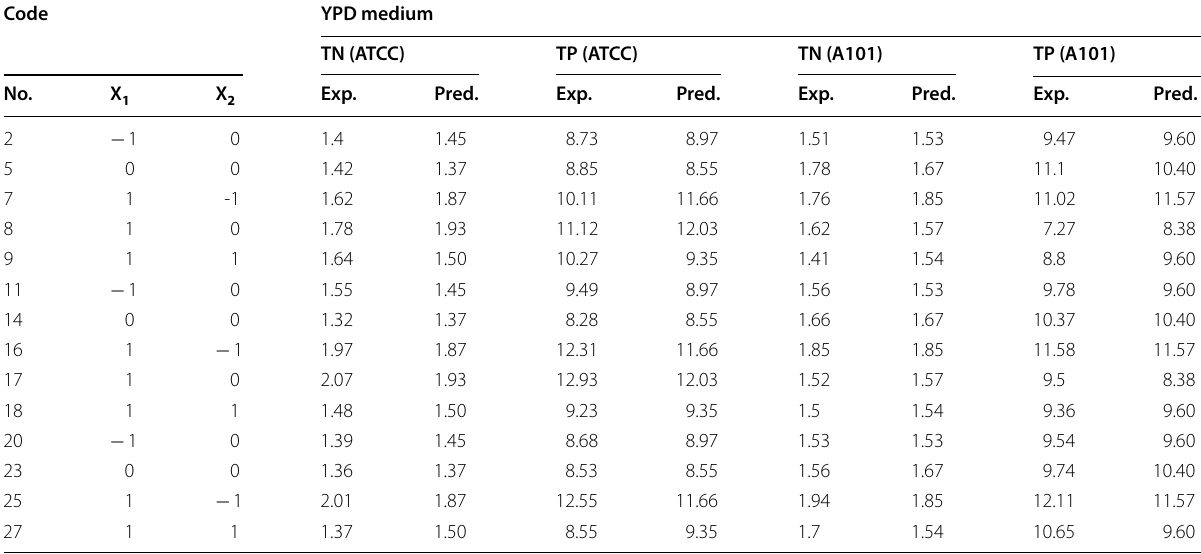
TN, total nitrogen; TP, total protein; Exp., experimental values; Pred., predicted values approximated from the Eq. (1); ATCC, Y. lipolytica ATCC 9793; A-101, Y. lipolytica A-101; YPD, YPD medium; SK, SK medium (biofuel production waste)